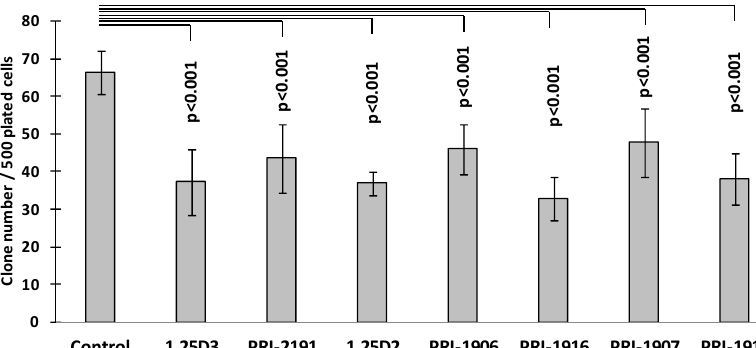
Figure 1. Structures of 1,25-dihydroxyvitamin D 3 (1,25D3), 1,25-dihydroxyvitamin D 2 (1,25D2), Figure 2. Vitamin D analogues decrease the clonogenicity of HT-29/5-FU cells undergoing renewal. analogue of 1,25D3 (PRI-2191) and analogues of 1,25D2 (PRI-1906, PRI-1916, PRI-1907 and PRI-1917). The bar graph represents a mean colony numbers ± standard deviation in control cultures and in cultures with 1,25-dihydroxyvitamin D3 (1,25D3), analogue of 1,25D3 (PRI-2191) 1,25- dihydroxyvitamin D2 (1,25D2), and analogues of 1,25D2 (PRI-1906, PRI-1916, PRI-1907 and PRI-1917). HT-29/5-FU cells were collected on the third day after the exposure to 5-FU and were plated in the clonogenicity assay in n = 6 replicates. Statistically significant differences between mean colony-forming cell number in control cultures and cultures with vitamin D analogues were determined by Dunnett’s test. Data from one of two experiments with similar results are shown.